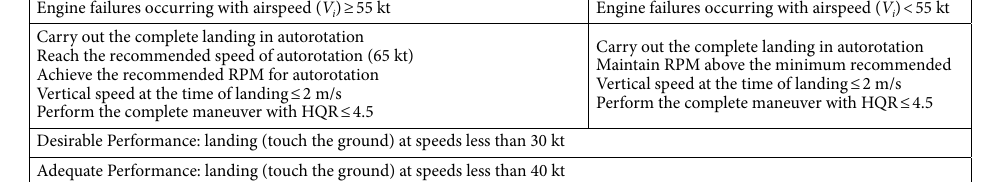
Table 2. Mission task element (MTE) for autorotation, adapted from ADS-33. Used for workload